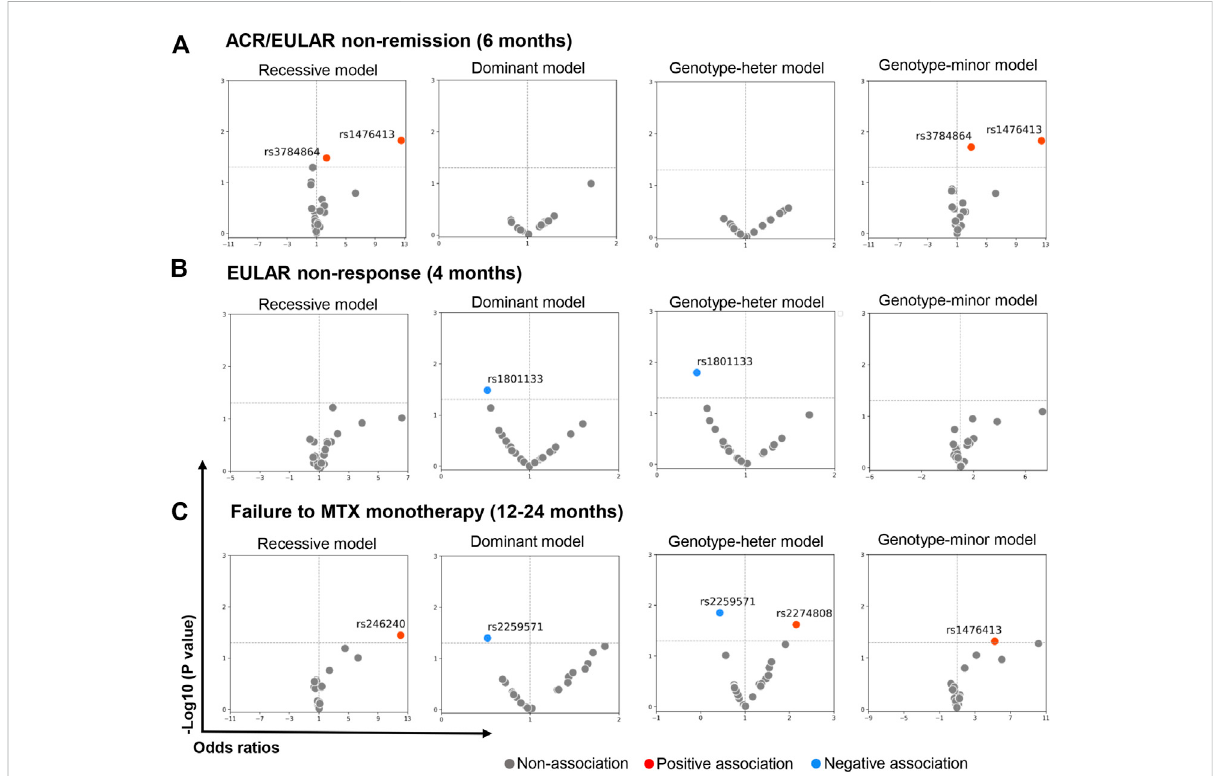
FIGURE 3 SNPs associated with MTX treatment inef fi ciency measured by categorical outcomes. Volcano fi gures showing SNPs signi fi cantly associated with MTX treatment inef fi ciency. Multivariate logistic regression (adjusted by gender, age, smoking, BMI) was implemented to calculate odds ratio and adjusted p -value (without Bonferroni correction) of each SNP. For those where case number in subgroups is zero, chi-square test was used and odds ratio was estimated by contingency table. MTX treatment inef fi ciency was measured by three criteria and denoted as ACR/EULAR non- remission at 6 months (A) , EULAR non-response at 4 months (B) and failure to MTX monotherapy from 12 to 24 months (C) . Recessive, dominant, genotype-heter and genotype-minor models were applied respectively. They are denoted as mm vs. MM + Mm (reference), mm + Mm vs. MM (reference), Mm vs. MM (reference) and mm vs. MM (reference) accordingly. The Bonferroni corrected p -value was estimated based on hypotheses tested on 23 SNPs to adjust signi fi cant results for multiple testing. The raw p -values (without Bonferroni correction adjustment) were also reported because of the exploratory nature of the analyses and to better highlight nuances in the results that would be less visible after correction. MM, major homozygote; Mm, heterozygote; mm, minor